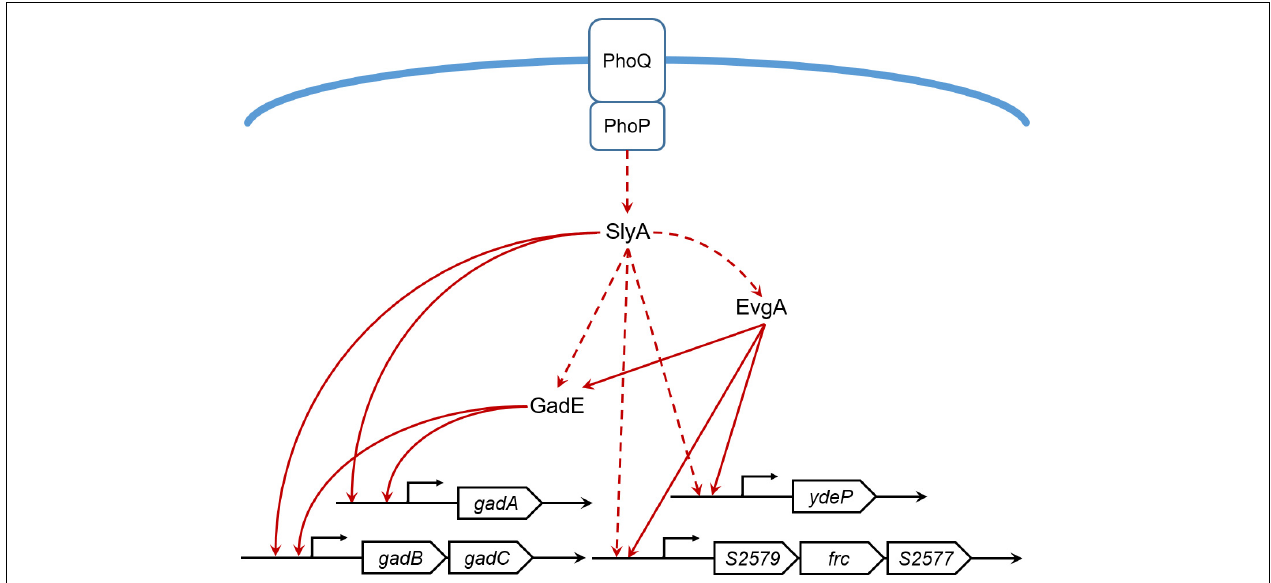
FIGURE 6 | The SlyA regulatory network of S. flexneri acid resistance. Solid lines indicate direct or experimentally verified transcriptional regulation. Dashed lines indicate hypothetical regulation inferred from our proteomic results or